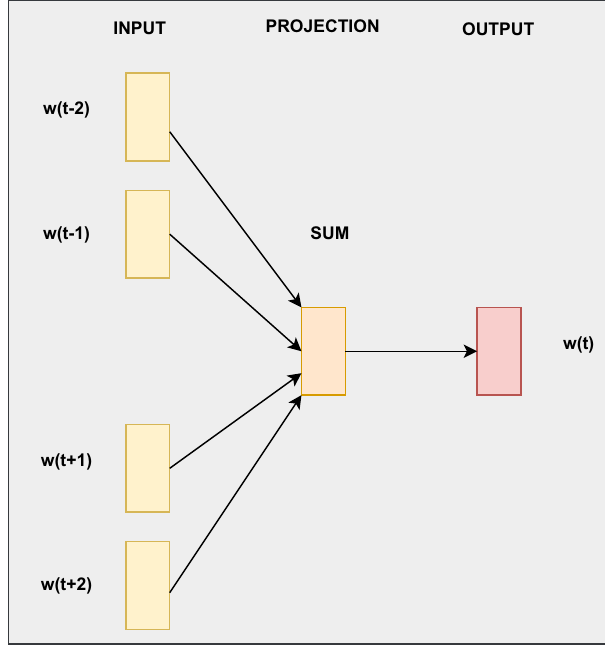
Figure 4: cBOW structure ( Source: https://arxiv.org/pdf/1301.3781.pdf Mikolov et al., 2013 )